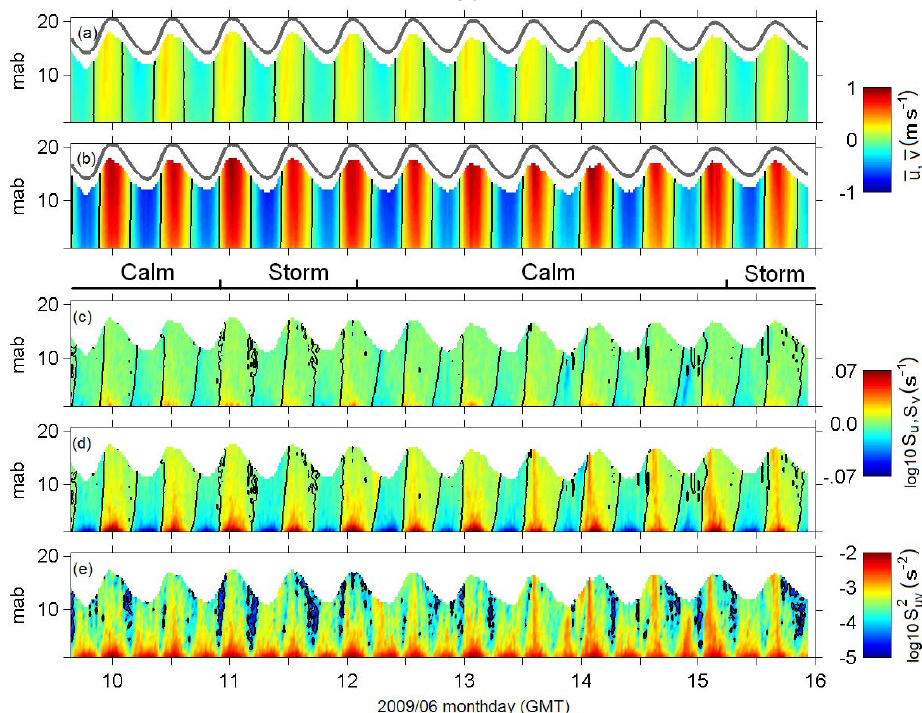
Fig. 3. Time-depth variability of (a) cross-shore mean current velocity ¯ u and (c) its shear S U = dv/dz , (b) along-shore mean current velocity, ¯ v and (d) its shear S V = dv/dz , and (e) shear velocity squared, S 2 uv . Sea level is marked by a bold solid line over the velocity components. Zero-mean velocity and shear components are marked by solid lines. The abbreviation “m.a.b.” denotes metres above the bottom. The storm and calm periods correspond to those indicated in Fig. 2.